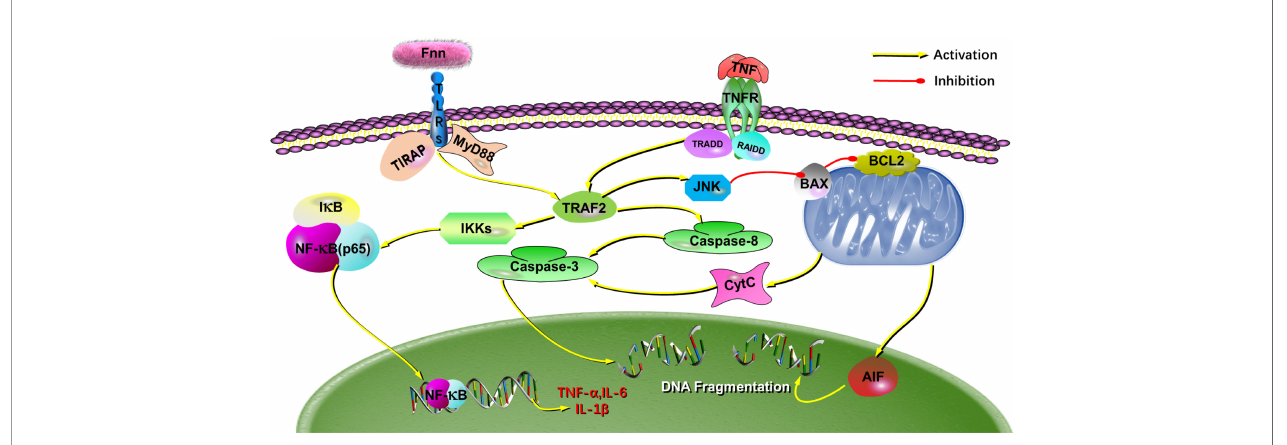
FIGURE 10 | The putative mechanism for the effects of F. necrophorum on the biological processes in cells. The schematic diagram depicts how F. necrophorum activates NF- k B and death receptor signaling pathways, inducing cell apoptosis and in fl ammatory response. TLRs, Toll-like receptors; I k B a , inhibitors of NF- k B; NF- k B, nuclear factor kappa